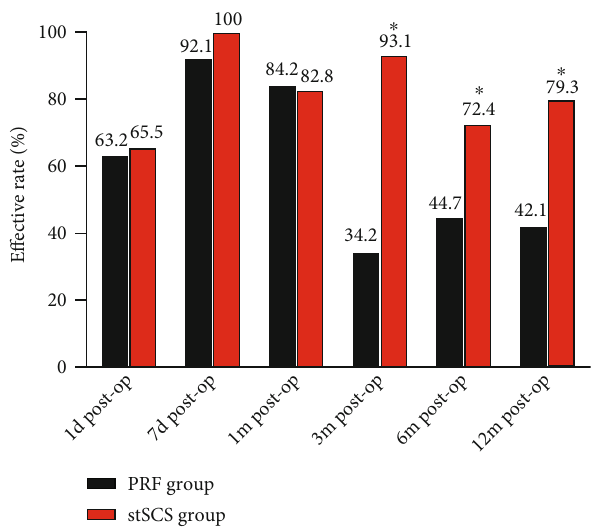
Figure 3: Pre- and postoperative VAS scores. ∗ P < 0 : 001 indicates post-operation vs. baseline. # P < 0 : 05 indicates PRF group vs. stSCS group.